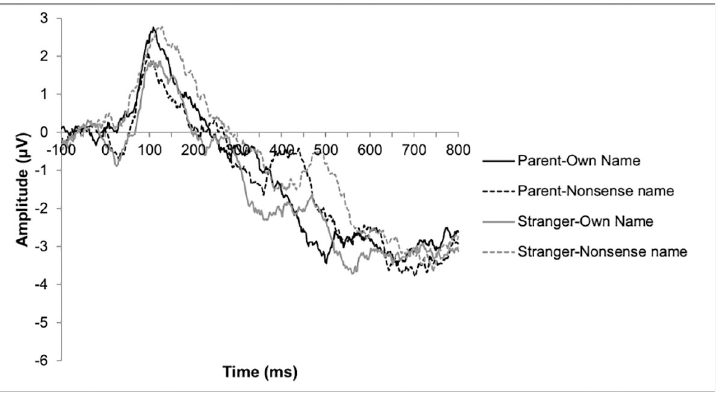
Fig 3. ERP waveforms over frontal regions in the ASD sample in each